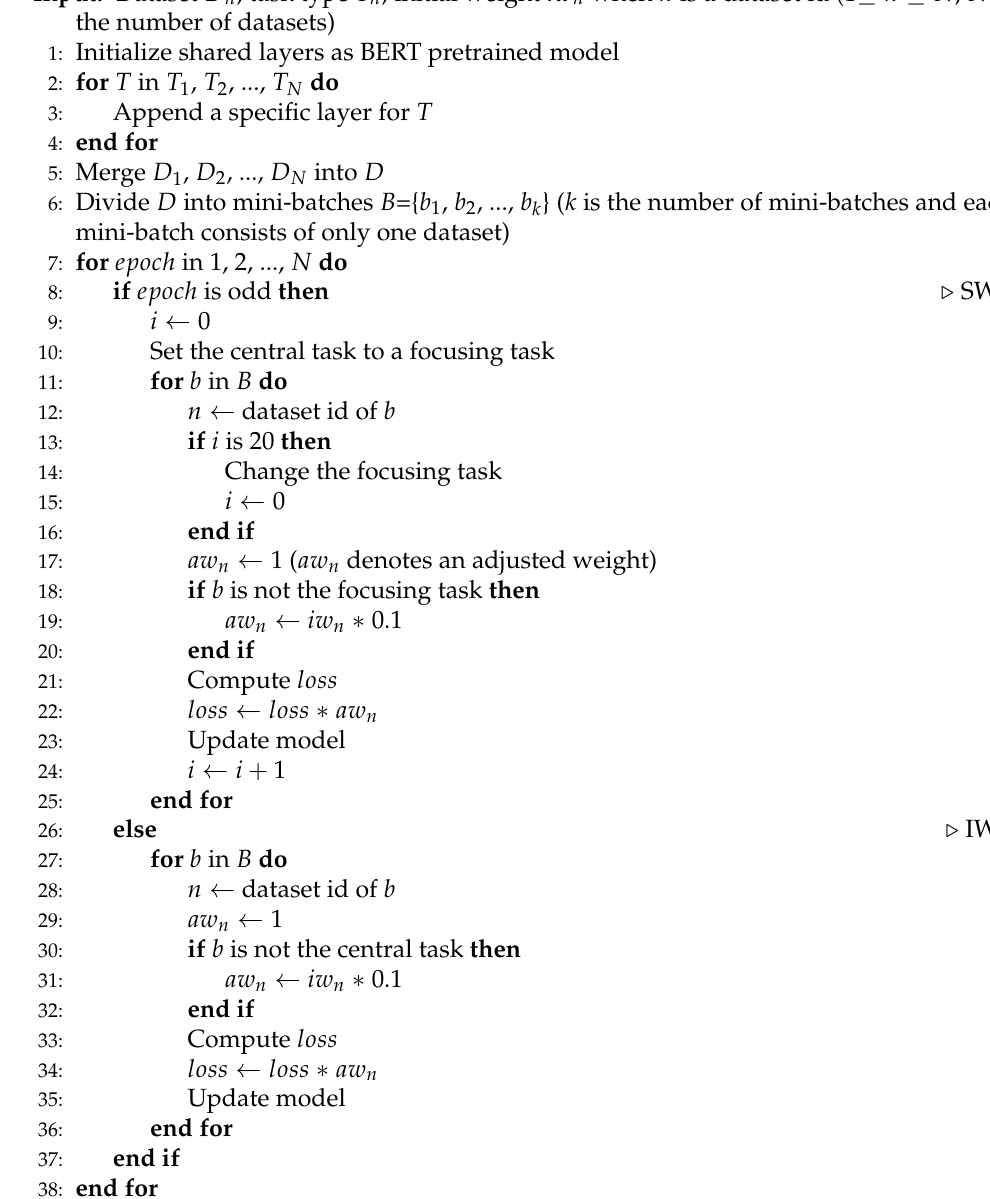
Algorithm 1 Sequential and intensive weighted